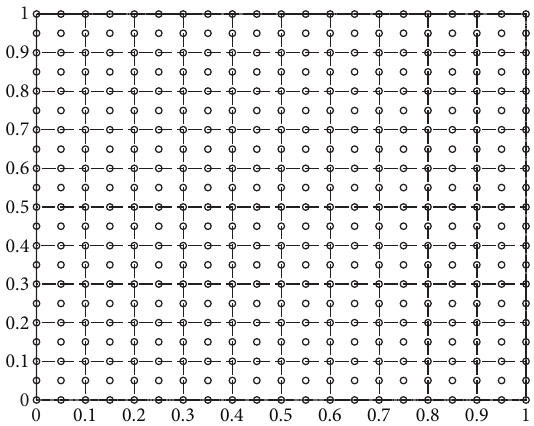
Figure 7: Typical node distribution for Poisson equation.